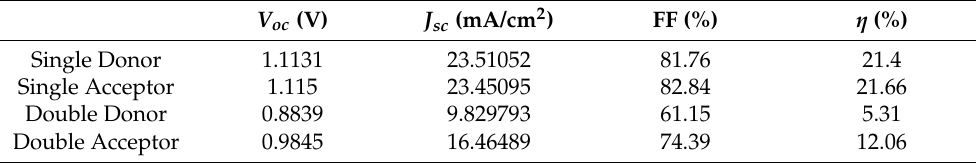
Table 4. Defect state effect on output characteristics of solar cell at trap density 10 16 cm − 3